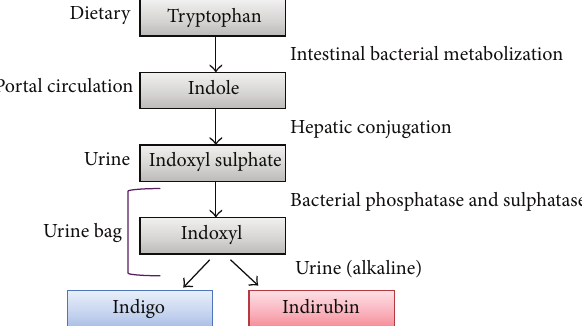
Figure 3: Pathogenesis of the purple urine bag syndrome (adapted from Hadano et al.